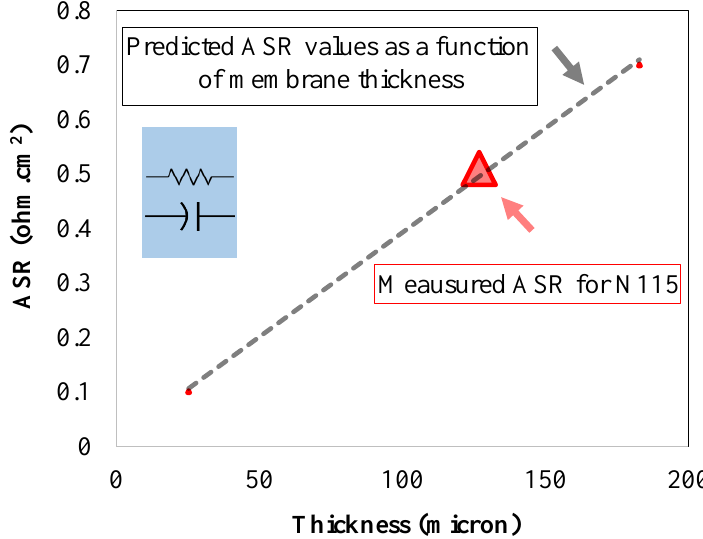
Figure 6. The ASR value for single-layer N115 and predicted ASR variation as a function of membrane thickness.